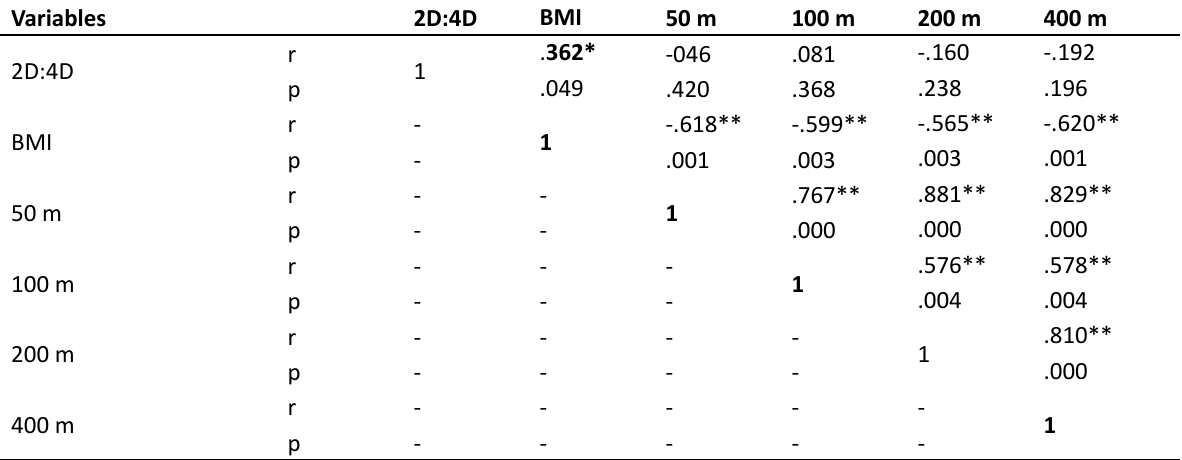
Table 3. Pearson correlation coefficient analysis of 2D:4D ratio and swimming performance time of participants.